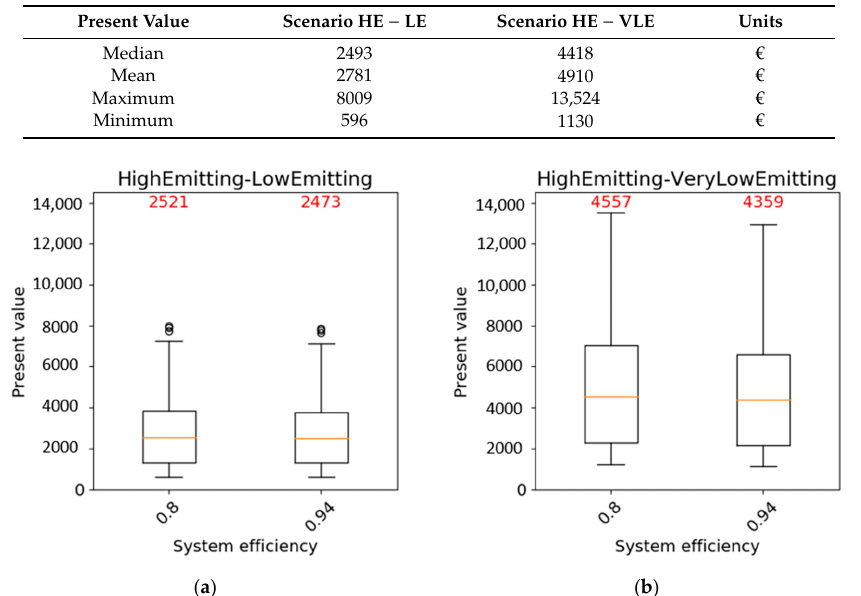
Figure 2. Present values in Euros calculated with different heating system efficiency values: 0.80 indicates a less efficient system (e.g., traditional non-condensing boiler) while 0.94 a very efficient